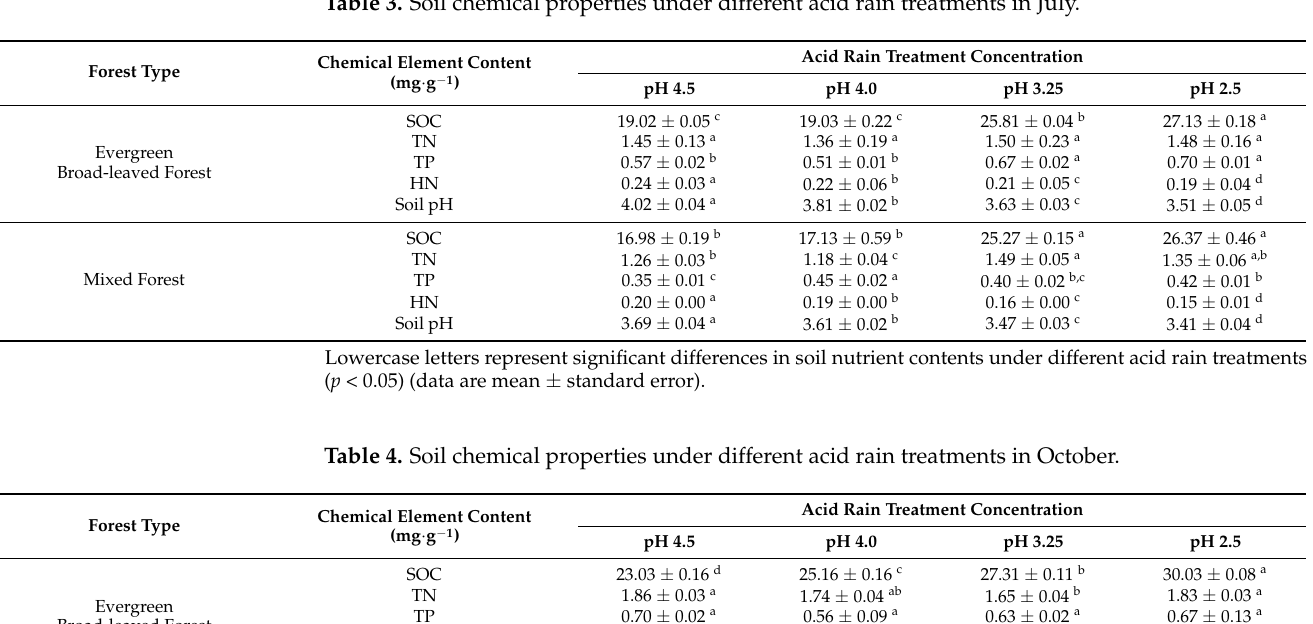
Table 3. Soil chemical properties under different acid rain treatments in July.